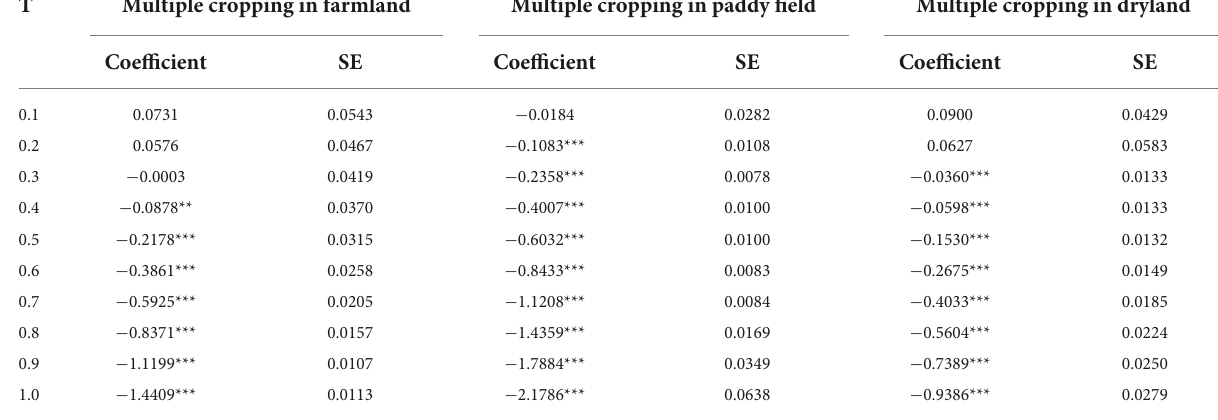
TABLE 10 Estimated results of generalized propensity score matching treatment effects before equivalence scale